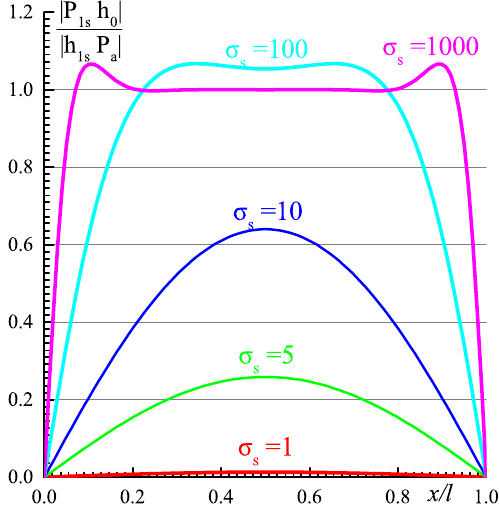
Figure 2. Distribution of P 1s inside of the 1D parallel